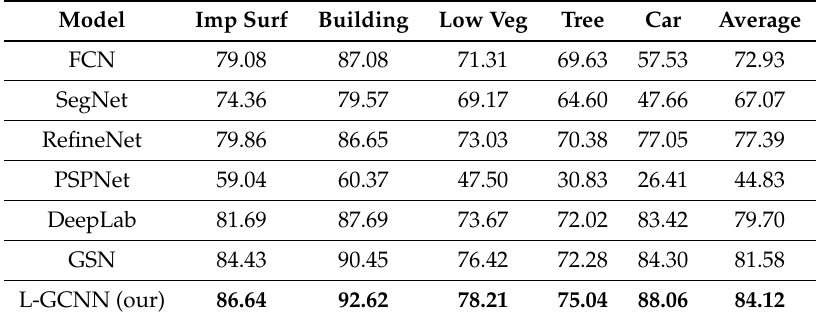
Table 3. IoU scores (%) obtained on Potsdam dataset.